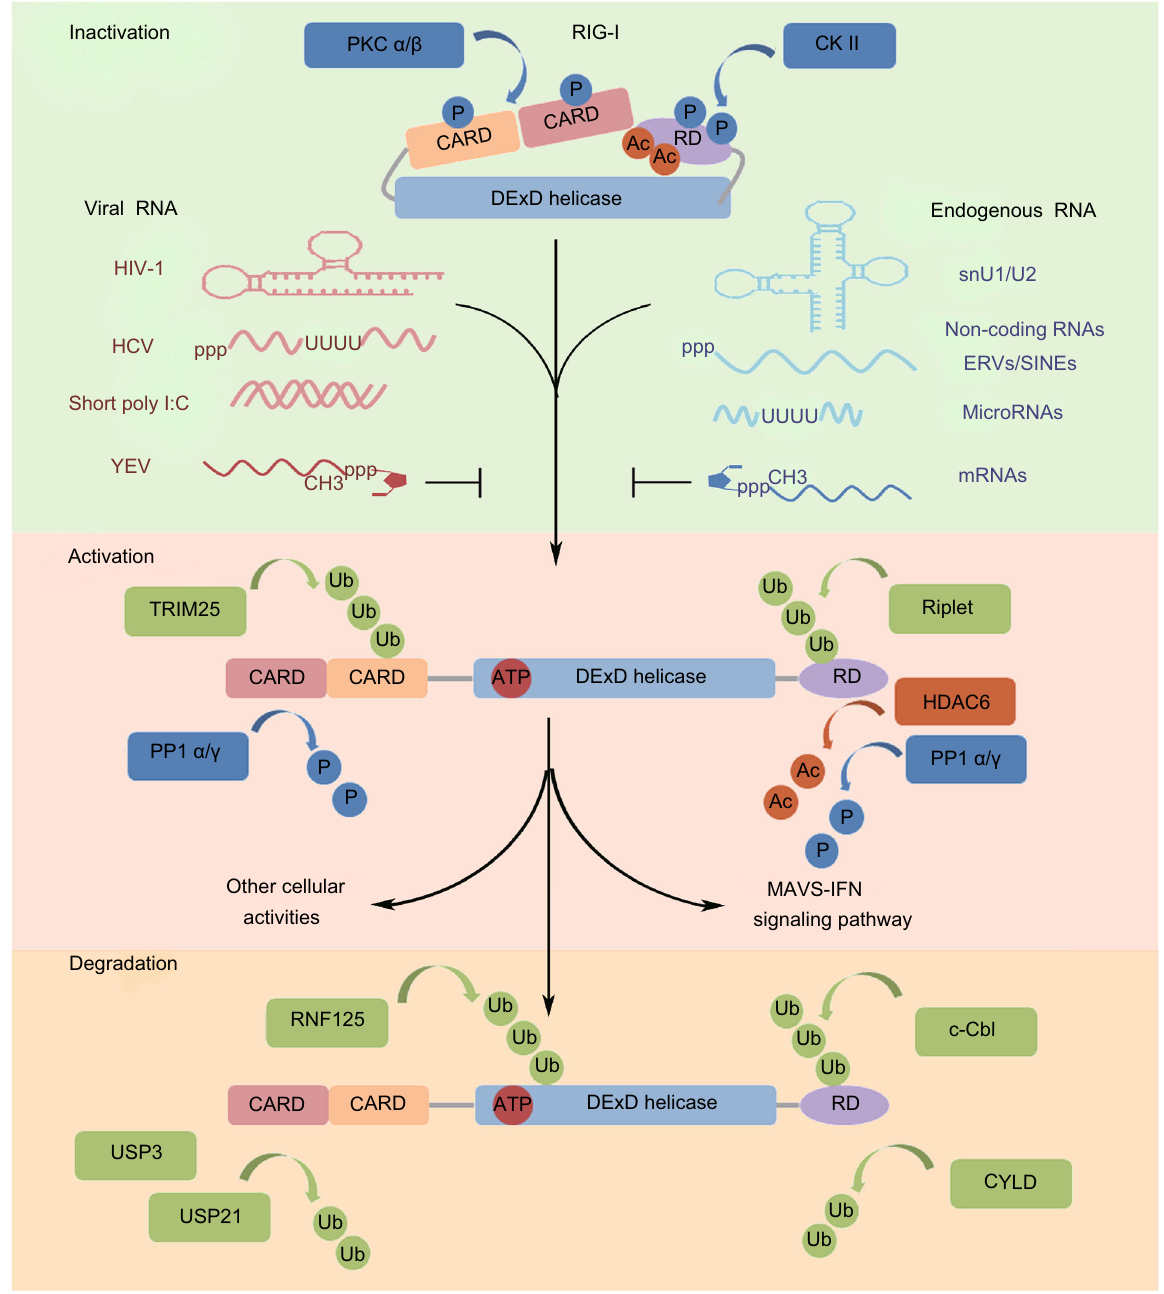
Figure 1. Various RNA ligands and post-translational regulations of RIG-I. Given the deepened and broadened study of RIG-I, various RNAs have been found to be recognized by RIG-I, including classical viral RNAs and some endogenous RNAs. The mRNAs are equipped with N1-2 ′ O-methylation of the m7 G cap structure to block RIG-I activation, which is also utilized by the yellow fever virus. Besides, RIG-I activation is accurately orchestrated by the post-translational modi fi cations, such as polyubiquitination, phosphorylation, and